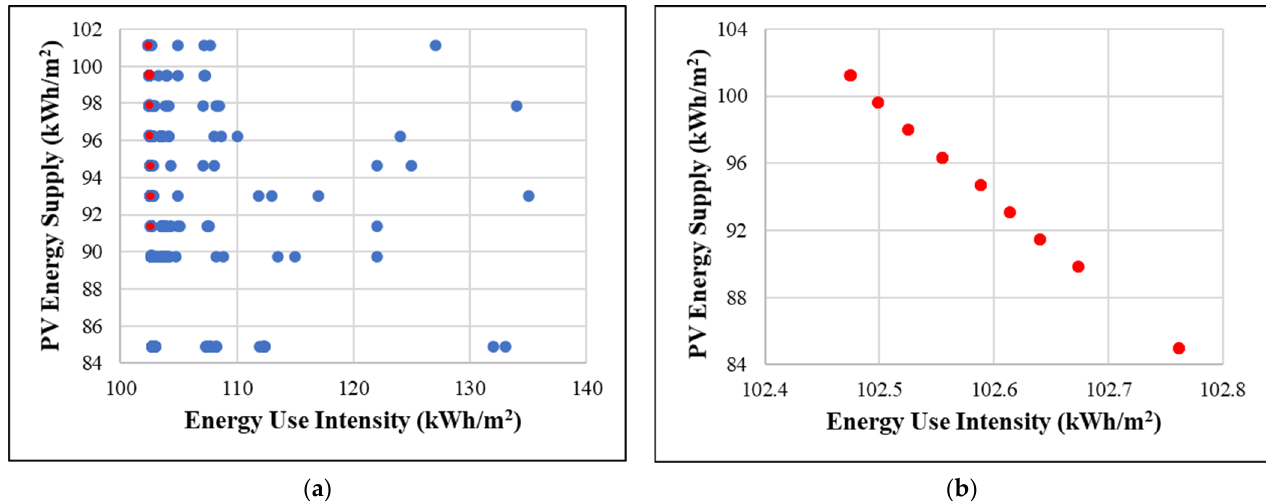
Figure 7. Scatterplot of energy use intensity against PV energy supply. ( a ) Entire solution space, ( b ) Pareto optimal solutions.